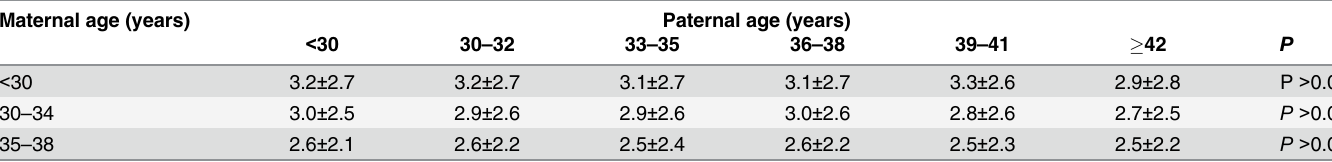
Table 3. Number of high-quality embryos in different age